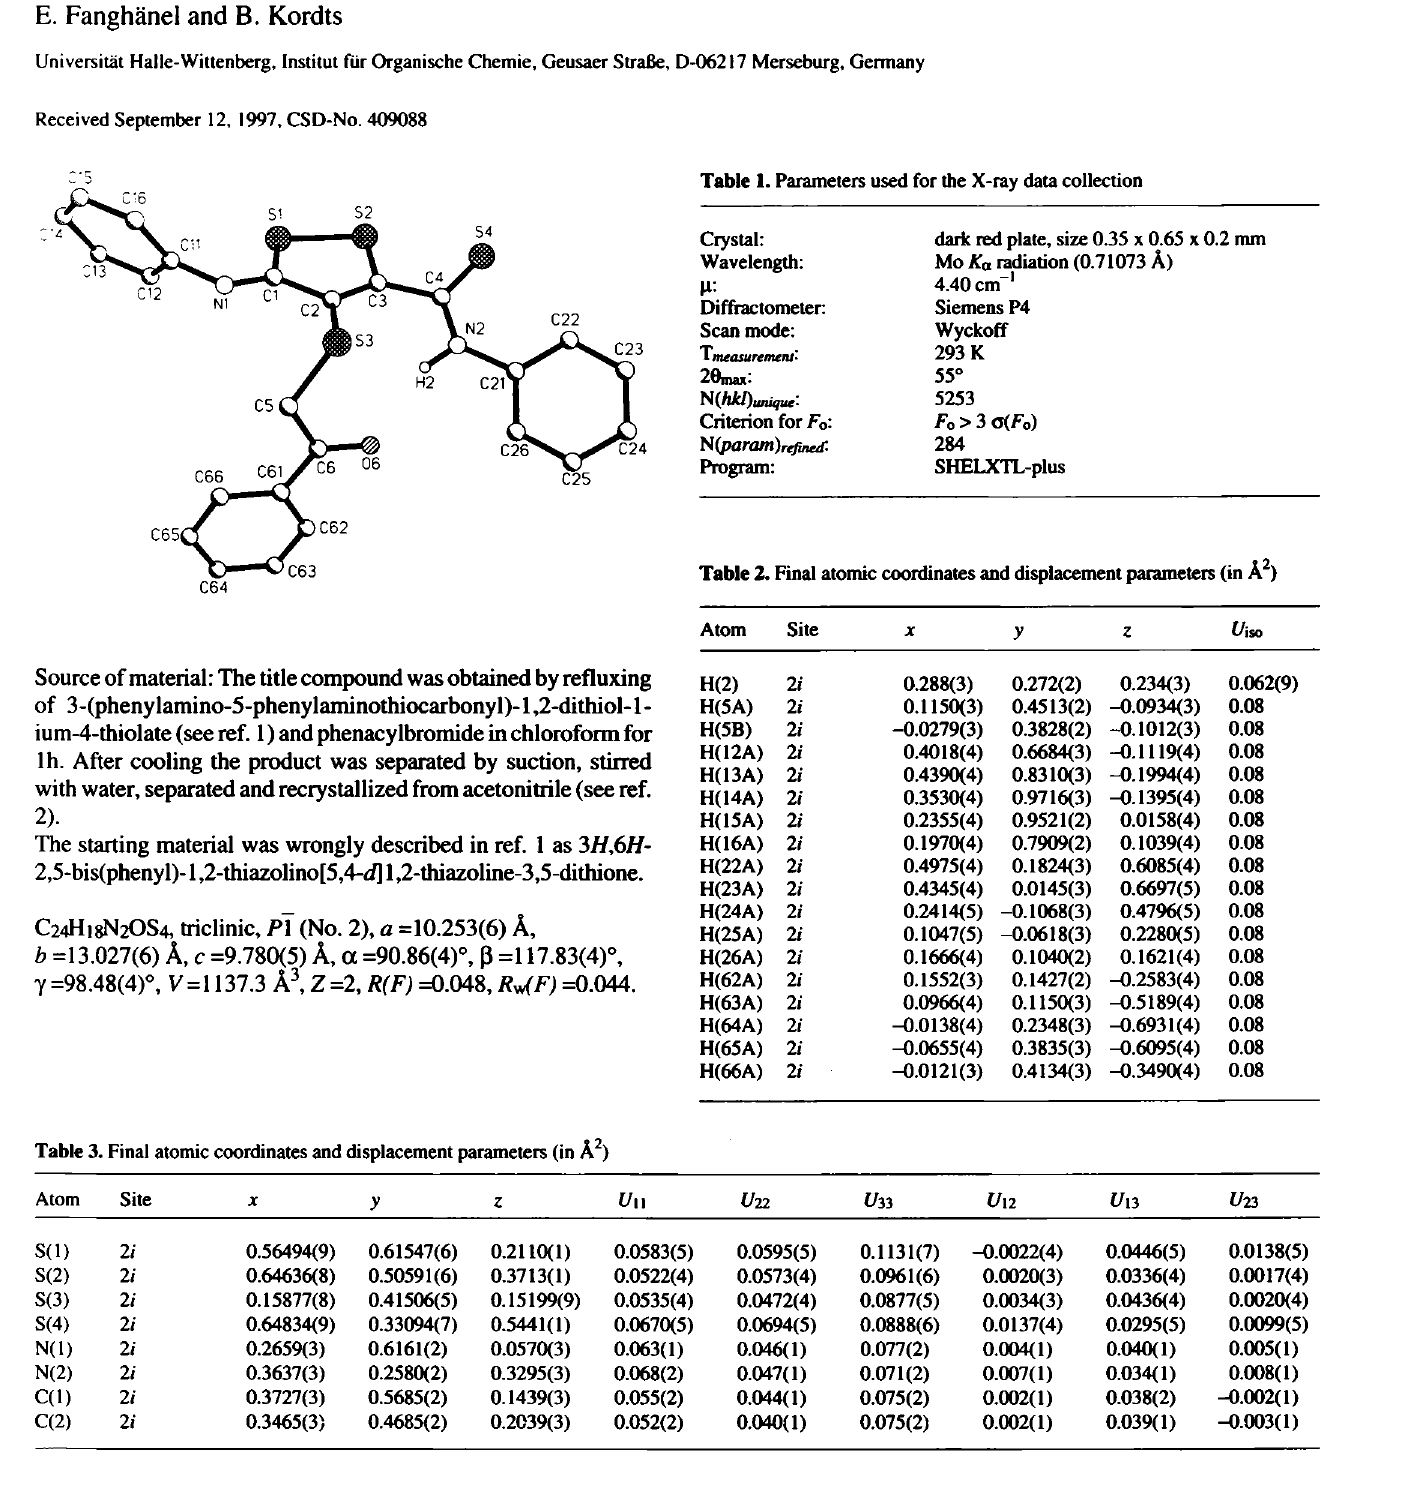
Table 1. Parameters used for the X-ray data collection Crystal: